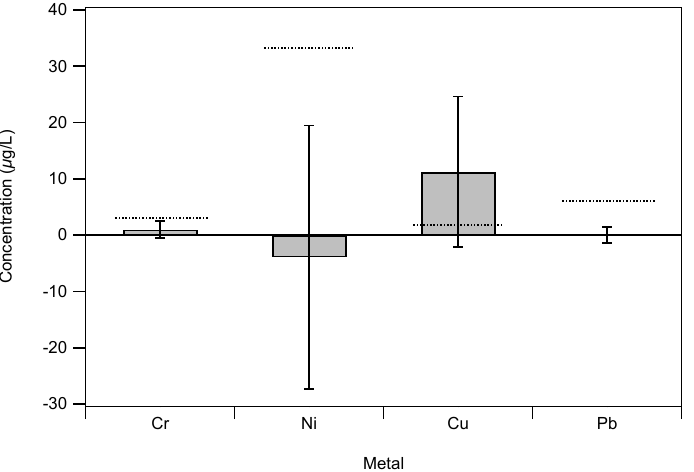
Figure A1. Mean of concentrations of chromium (Cr), nickel (Ni), copper (Cu), and lead (Pb) in the e − liquid placed in the tank measured before firing the e − cigarette. Error bars represent standard deviations of triplicate measurements. The dotted lines represent the Limits of Quantitation (LOQ) of the